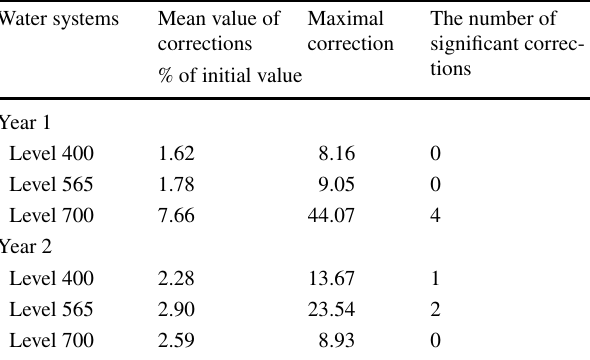
Table 4 Data for the assessment of balances of the studied water sys‑ tems of "Jankowice" mine Water